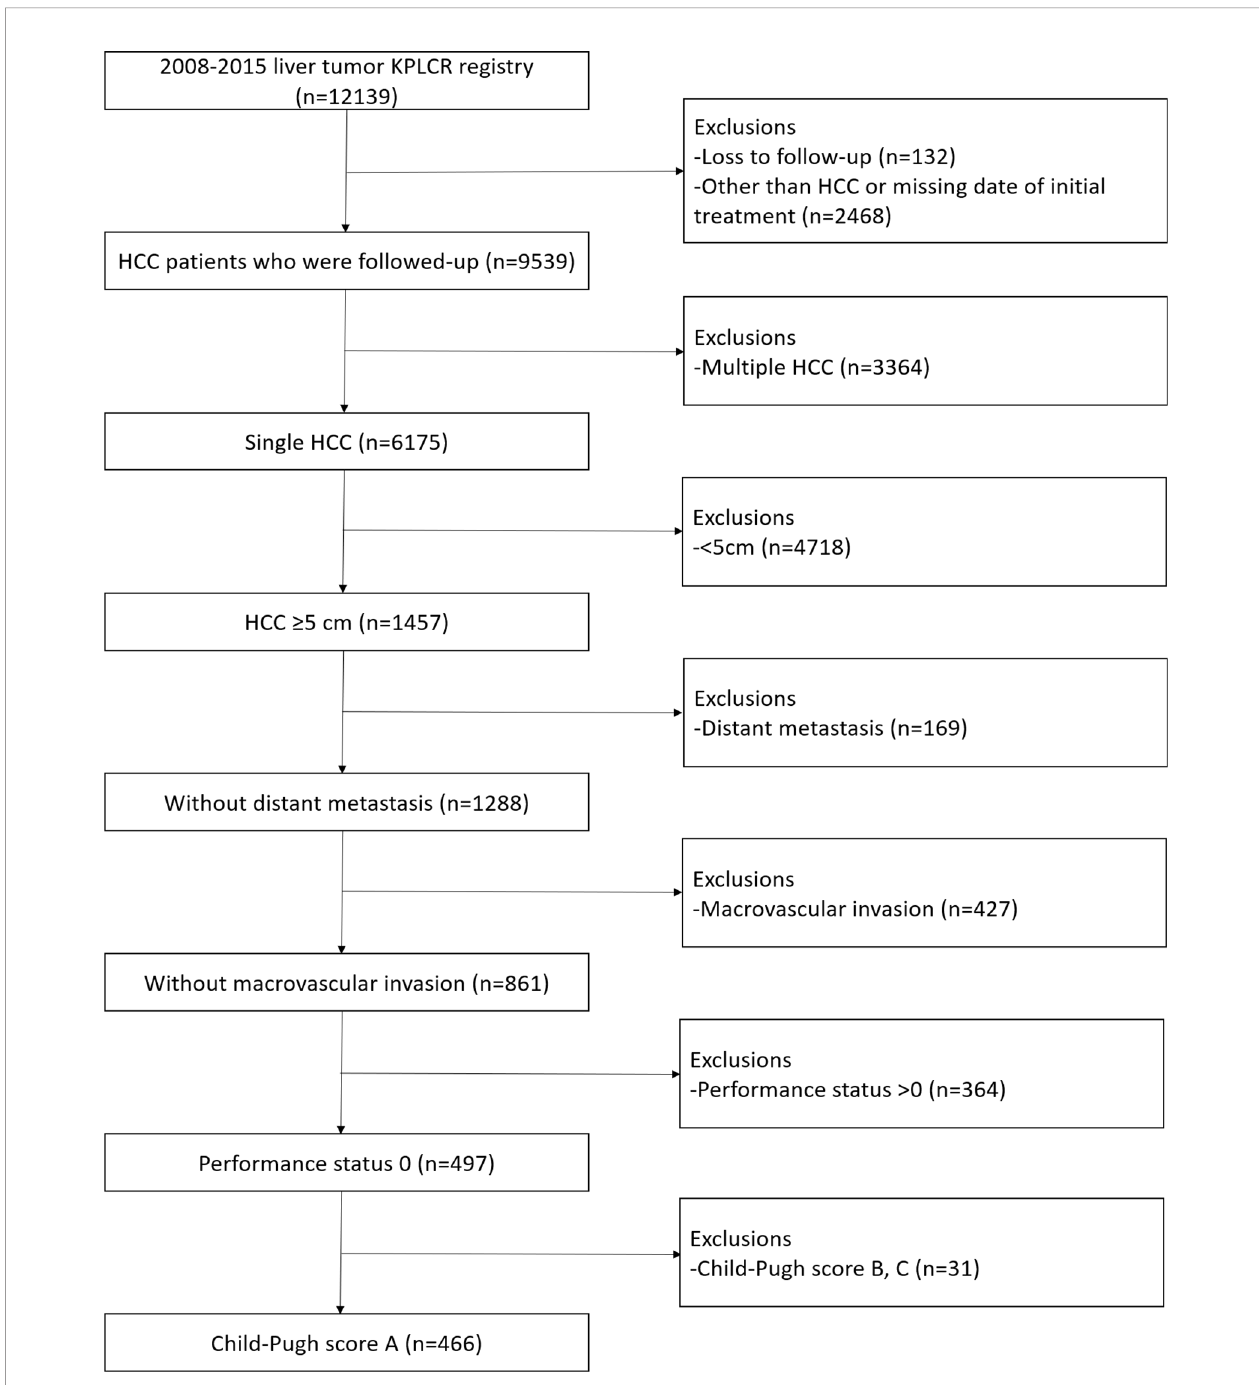
FIGURE 1 | Flowsheet of the enrolled